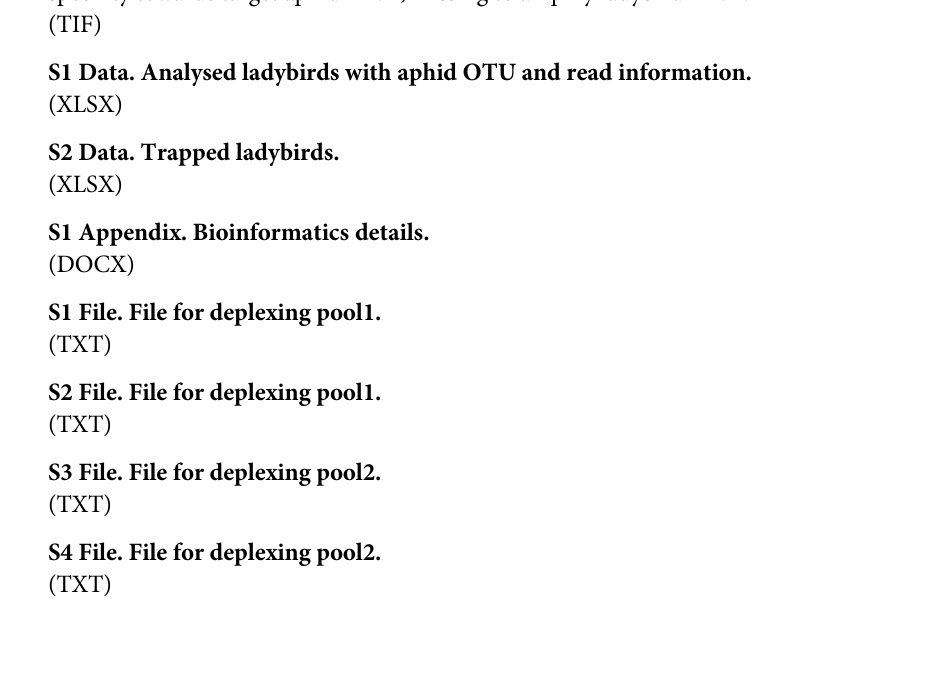
S4 Fig. In vitro comparison of primers. The modified primers of this study show increased specifity towards target aphid DNA, missing to amplify ladybird DNA. S1 Data. Analysed ladybirds with aphid OTU and read